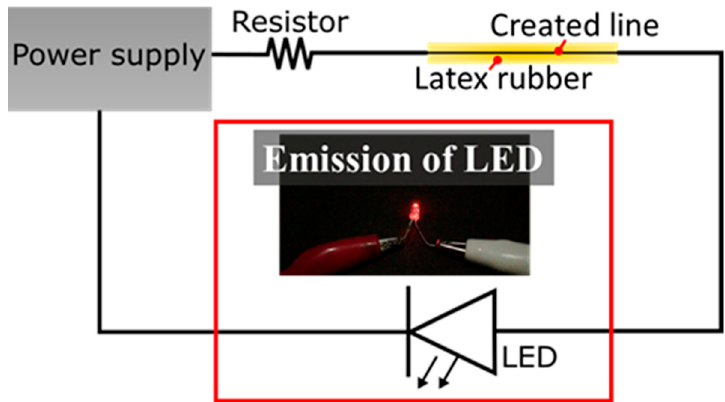
Figure 11. Electrical schematic to confirm the energization of the created line using LED. The LED was connected to the power supply via a resistor (3.3 k Ω ) and the created line on the latex rubber.